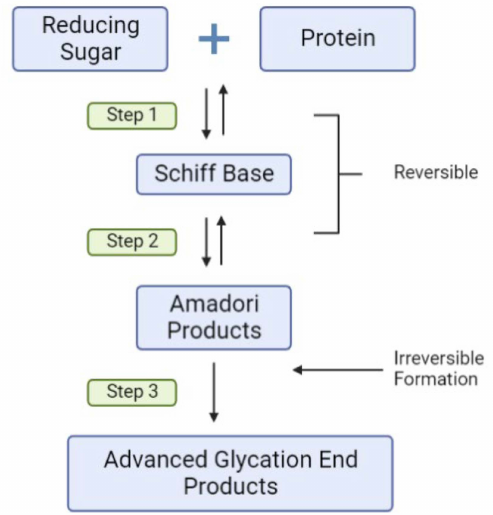
Figure 3. The basic chemistry of AGE Formation. Reducing sugars such as D-glucose, fructose, ribose and reactive dicarbonyls, including methylglyoxal, interact with amine groups such as lysine, tyrosine and arginine on proteins and peptides. Following various reversible chemical transition stages, the irreversible formation of advanced glycation end products such as N ε carboxymethyllysine modifications, HbA 1C , fructosamine albumin and methylglyoxal hydroimidazolones